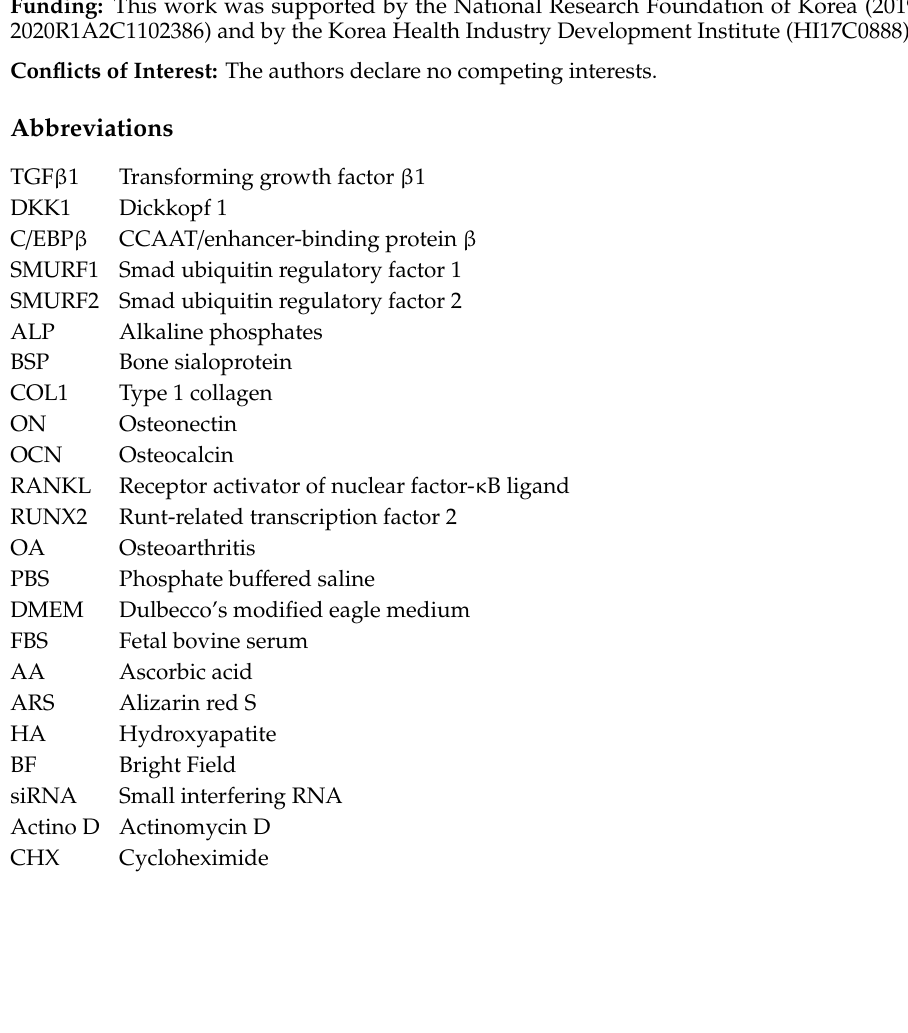
Figure S1. E ff ect of TGF β 1 on osteoprogenitors. Figure S2 TGF β 1 had no e ff ect on C / EBP β transcription level in osteoprogenitors, Figure S3. TGF β 1 decreased C / EBP β protein expression, Figure S4. TGF β 1 induced SMURF1 promoter, Figure S5. Suppression e ffi ciency of siSMURF1 in osteoprogenitors, Figure S6. Osteonectin did not a ff ect osteoblastic di ff